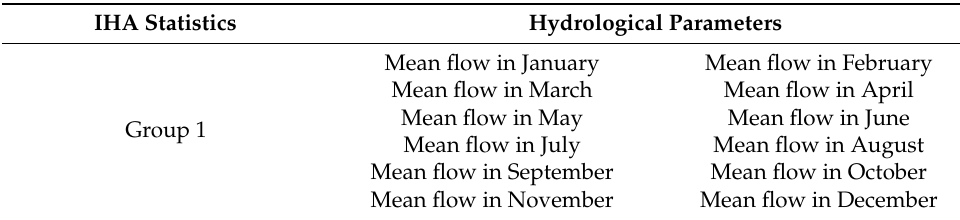
Table 1. IHA statistics (Group